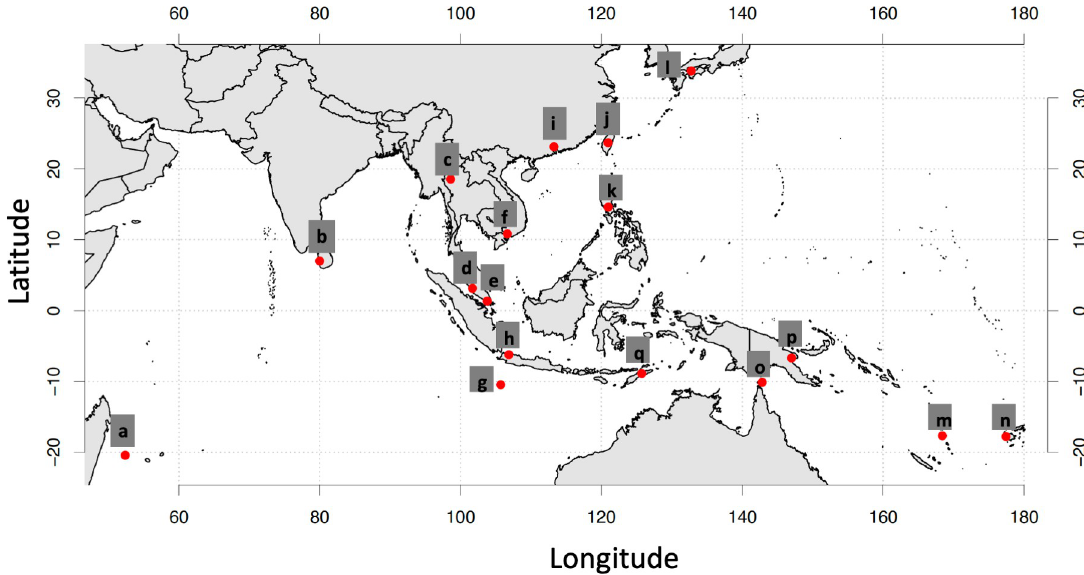
Fig 1. Approximate locations of the 17 Aedes albopictus populations. The map was made with R Package mapdata. Each letter corresponds to a collection from a different country. Note that in some cases multiple samples from nearby locations were combined (Table